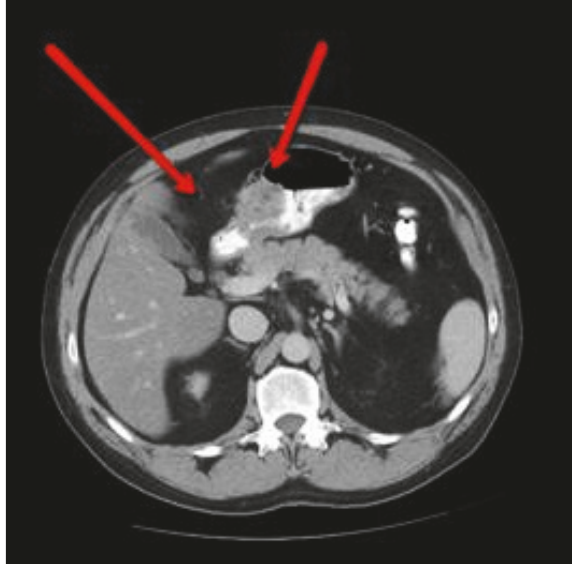
Figure 2: CT scan with IV contrast. Perigastric inflammatory changes are minimal (left arrow). Focal heterogeneous gastric thickening, consistent with residual inflammatory changes (right arrow).